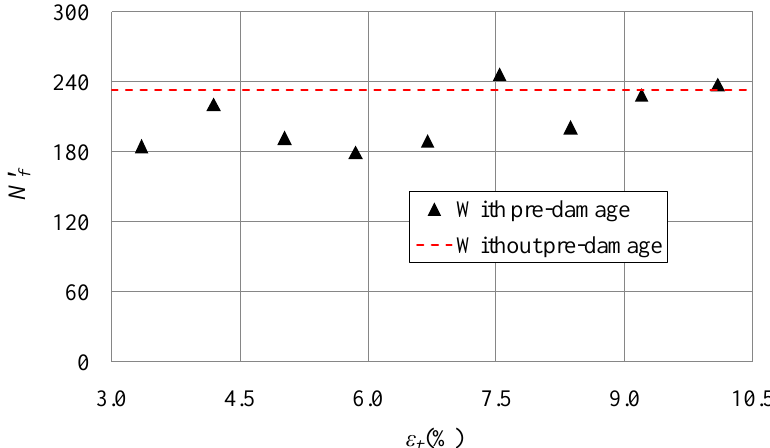
Figure 10. The remaining low-cycle fatigue lives considering prior tensile deformation damages.